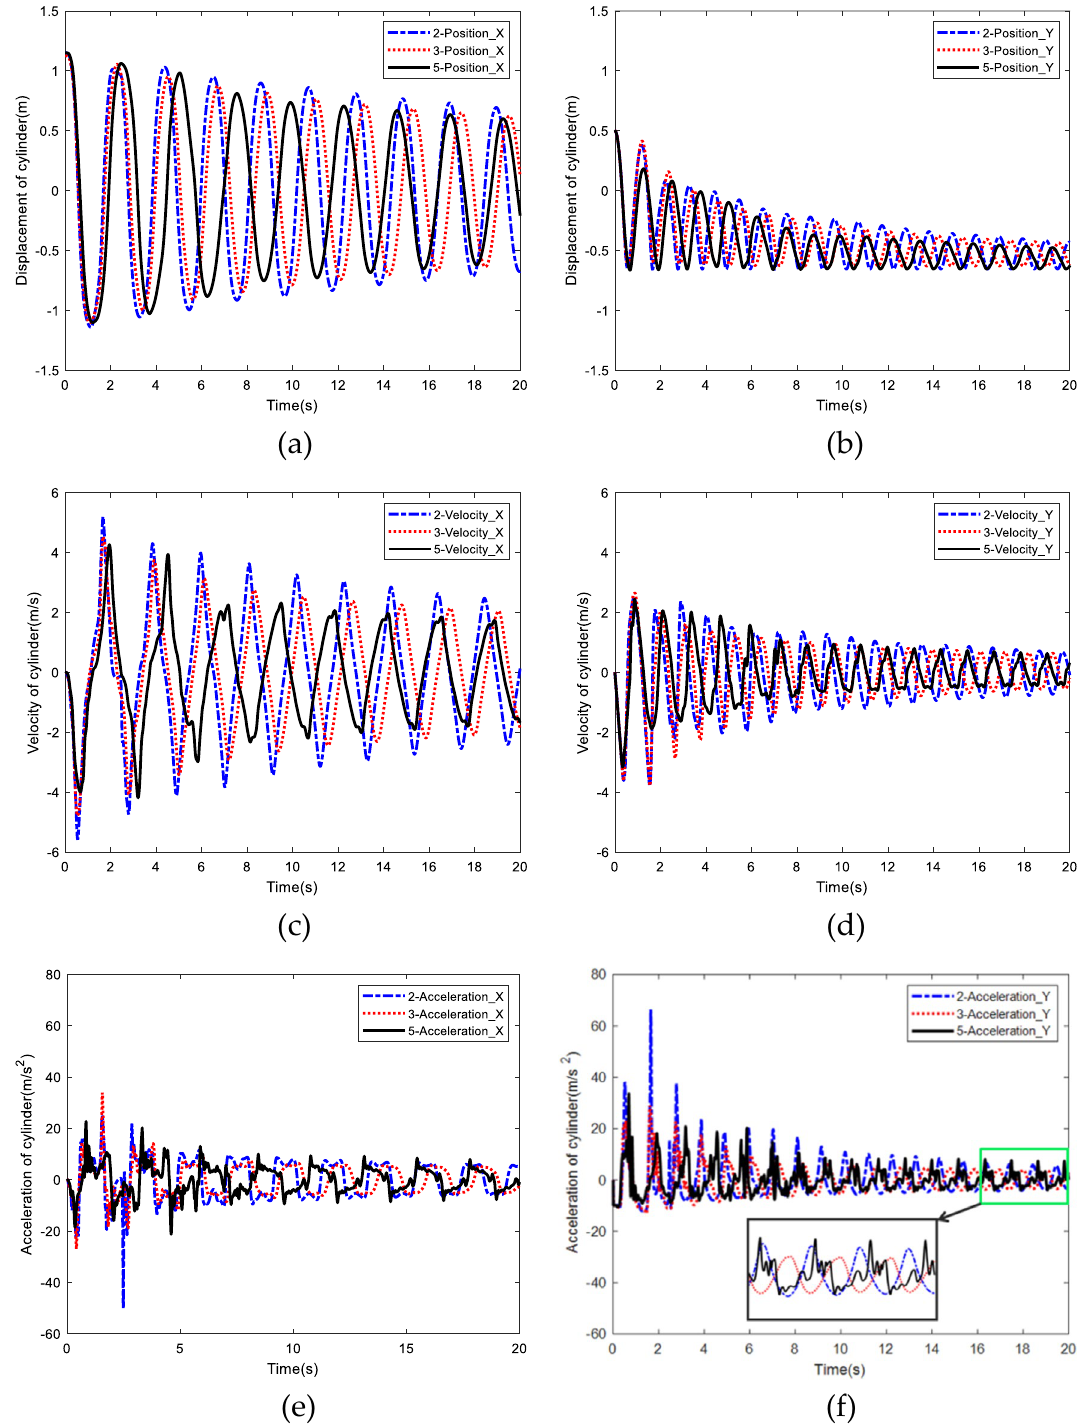
Figure 12. Comparison of different pattern of rigid body distribution. ( a ) Displacement in the X direction. ( b ) Displacement in the Y direction. ( c ) Velocity in the X direction. ( d ) Velocity in the Y direction. ( e ) Acceleration in the X direction. ( f ) Acceleration in the Y